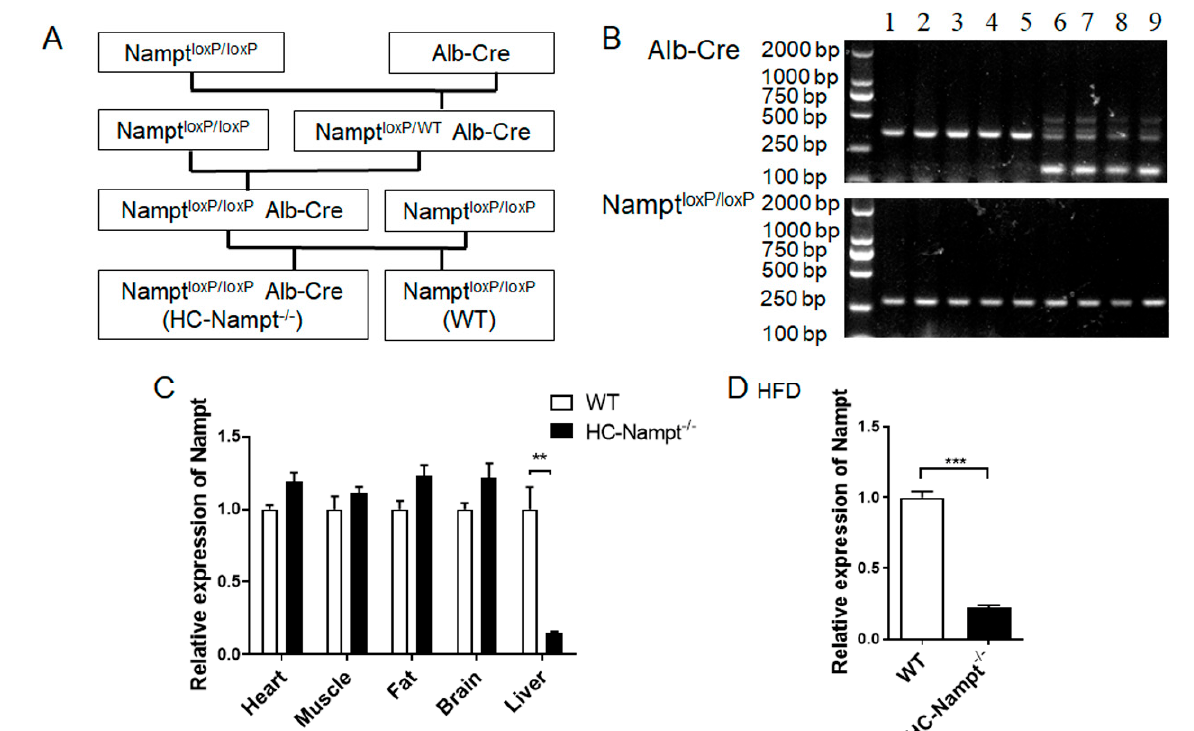
Figure 1. Generating hepatocyte-specific Nampt knockout (HC-Nampt -/- ) mice. ( A ) Breeding strategy for generating HC-Nampt -/- mice. ( B ) The genotypes of HC-Nampt -/- and WT mice. Lanes 1–5: Nampt loxP/loxP , also represent as WT. Lanes 6–9: Nampt loxP/loxP Alb-Cre, also represent as HC-Nampt -/- . ( C ) Nampt mRNA expression was detected by real-time PCR in various tissues of adult mice fed NCD. n = 5 (WT) or 4 (HC-Nampt -/- ). ( D ) Nampt mRNA expression was detected by real-time PCR in liver of the mice fed HFD for 10 weeks. n = 6 (WT) or 8 (HC-Nampt -/- ). Data are expressed as the mean ± SEM. Relative levels of HC-Nampt -/- mRNA were normalized to WT, respectively. ** p < 0.01 and *** p < 0.001 between two groups by two-tailed student’s t